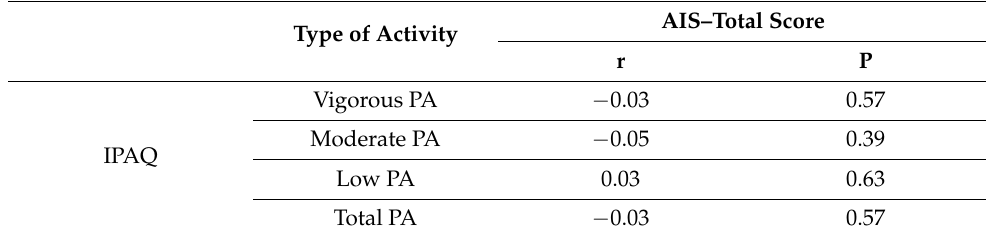
Table 3. Relationships between insomnia (AIS) and physical activity level (International Physical Activity Questionnaire, IPAQ), ( n =